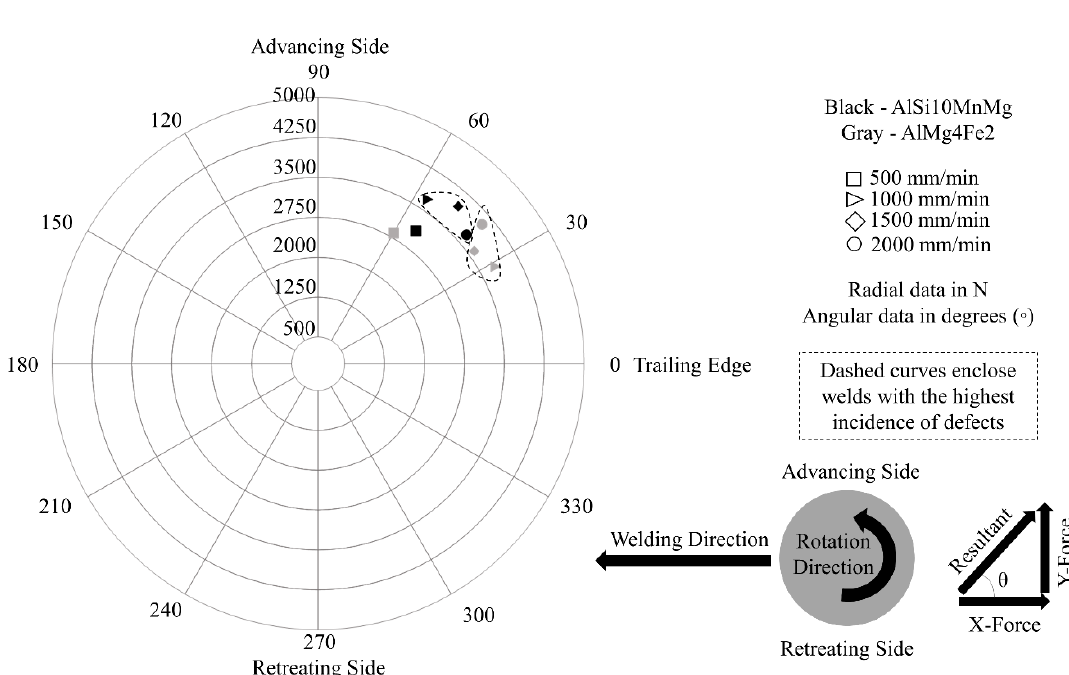
Figure 12. Polar plots of average in plane-reaction resulting forces on FSW tool for the AlSi10MnMg and AlMg4Fe2 welds .